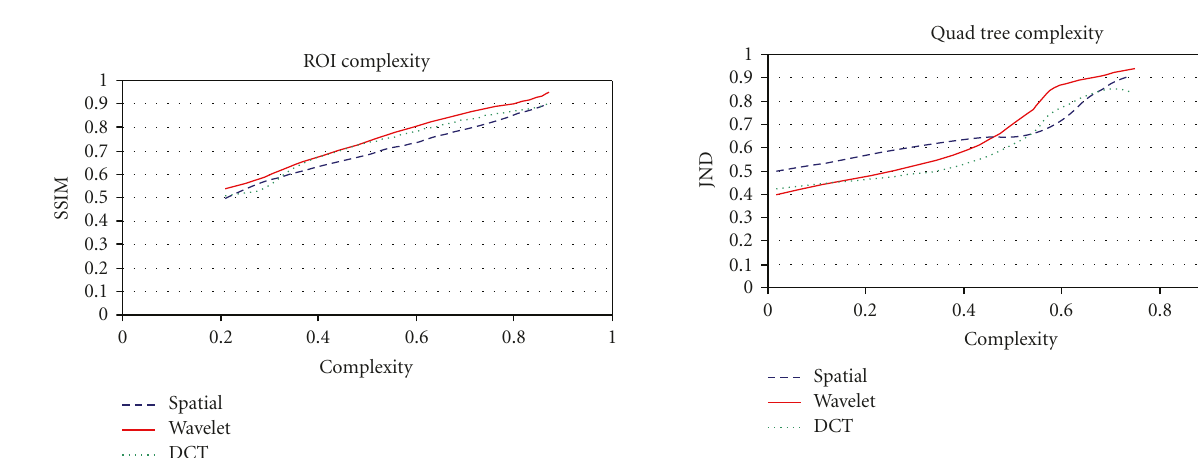
Figure 5: Relation between SSIM and Fractal complexity measure (averaged on 2000 images).